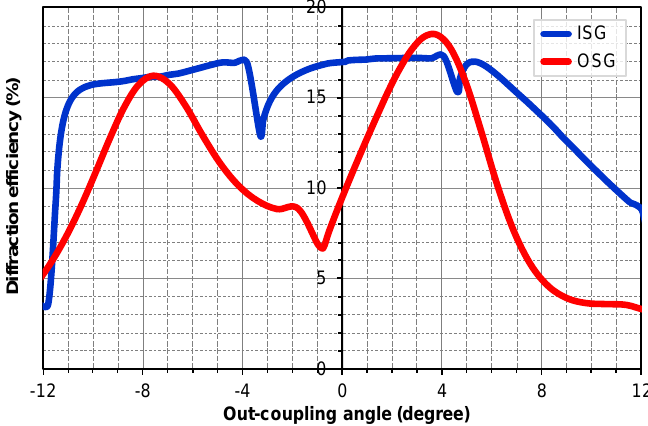
Figure 9. Di ff raction e ffi ciencies of the ISG and OSG calculated with respect to the out-coupling angle for the wavelength of 565 nm. The average DEs of the ISG and OSG over the full horizontal / vertical FOV ( ± 12 ◦ ) are 14.40% and 10.53%,